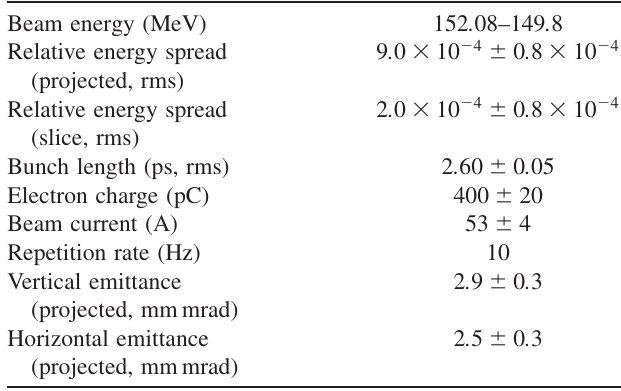
TABLE I. Main beam parameters measured during the experi- ment. The error figures represent 1 standard deviation over 20 acquisitions (except for the charge which is obtained with 100 acquisitions). The slice energy spread uncertainty is instead calculated as the standard deviation of the energy spread aver- aged over the bunch length, in a single shot